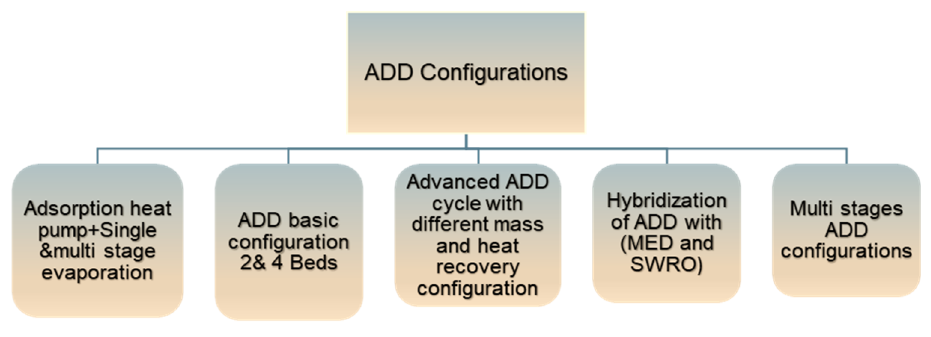
Figure 8. Classification of ADD configurations.